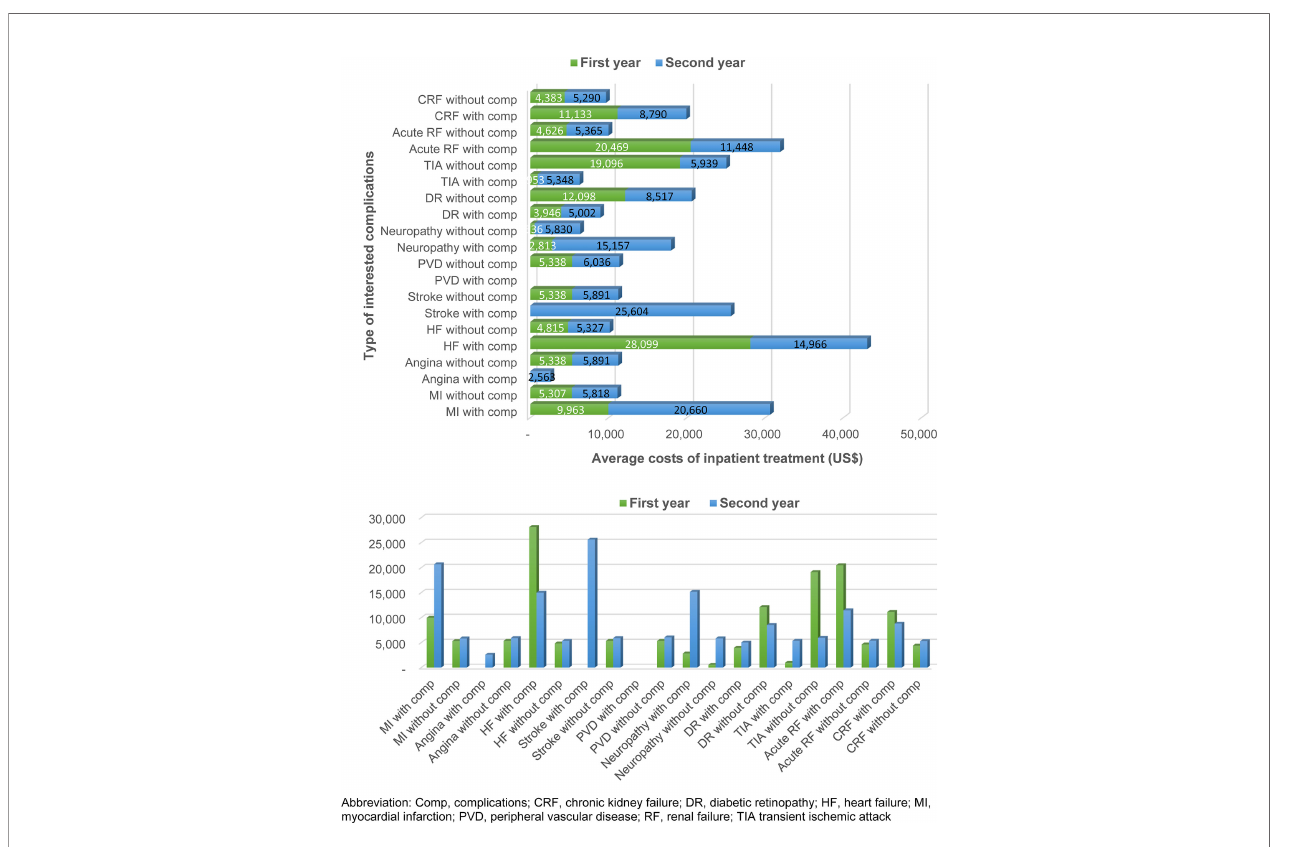
FIGURE 3 | Inpatient treatment costs for type 2 diabetes with and without interested